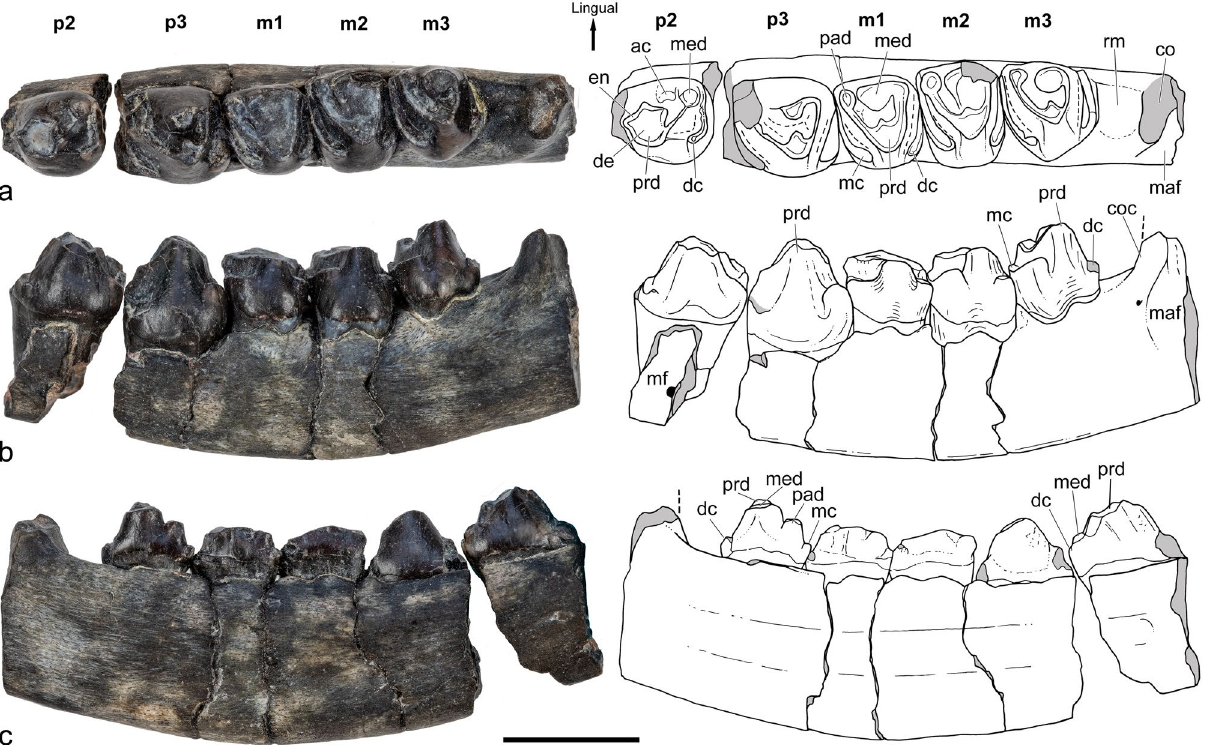
Figure 2. Orretherium tzen gen. et sp. nov. (CPAP-5007, holotype). ( a – c ) Partial left dentary with p2-p3 and m1-m3 in occlusal ( a ), labial ( b ) and medial ( c ) views. Drawings made by A.G.M. ac accessory cusp,